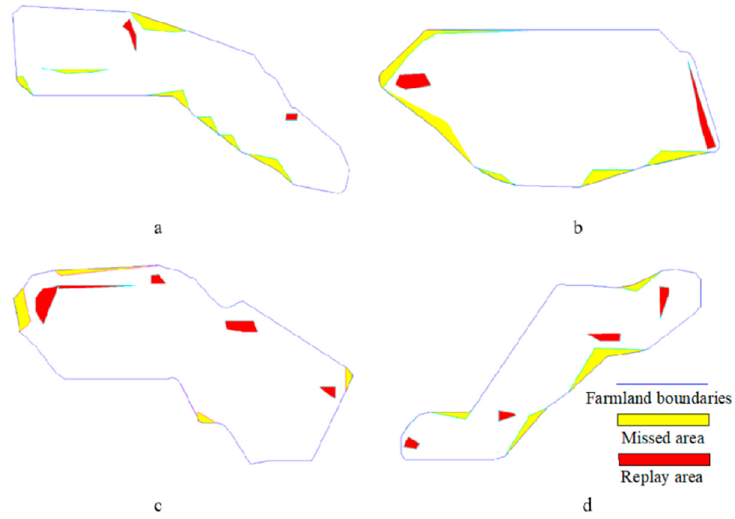
Figure 13. Validation of the replay and missed area. ( a ) Field Block 1; ( b ) field block 2; ( c ) field block 3; ( d ) field block 4.